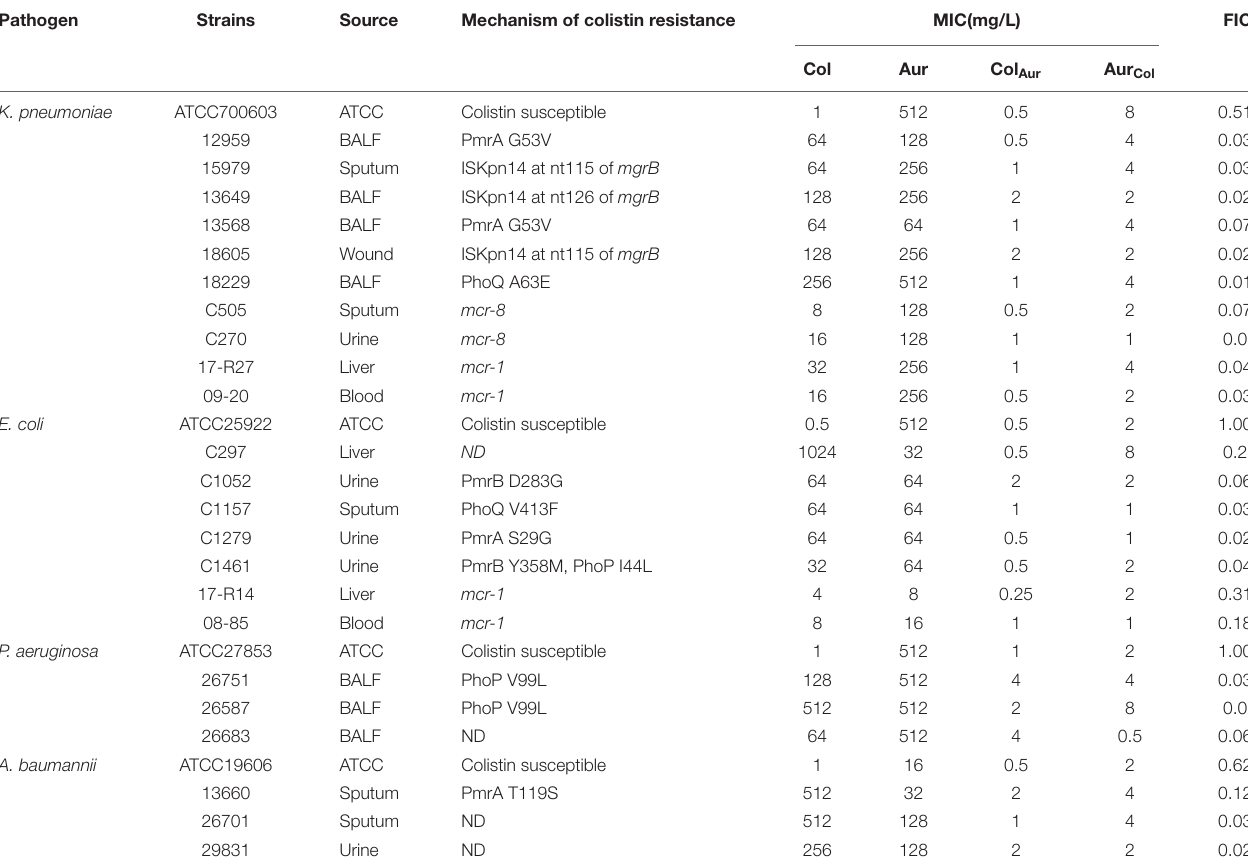
TABLE 1 | Checkerboard assays showing the effects of colistin combined with auranofin. Pathogen Strains Source Mechanism of colistin resistance